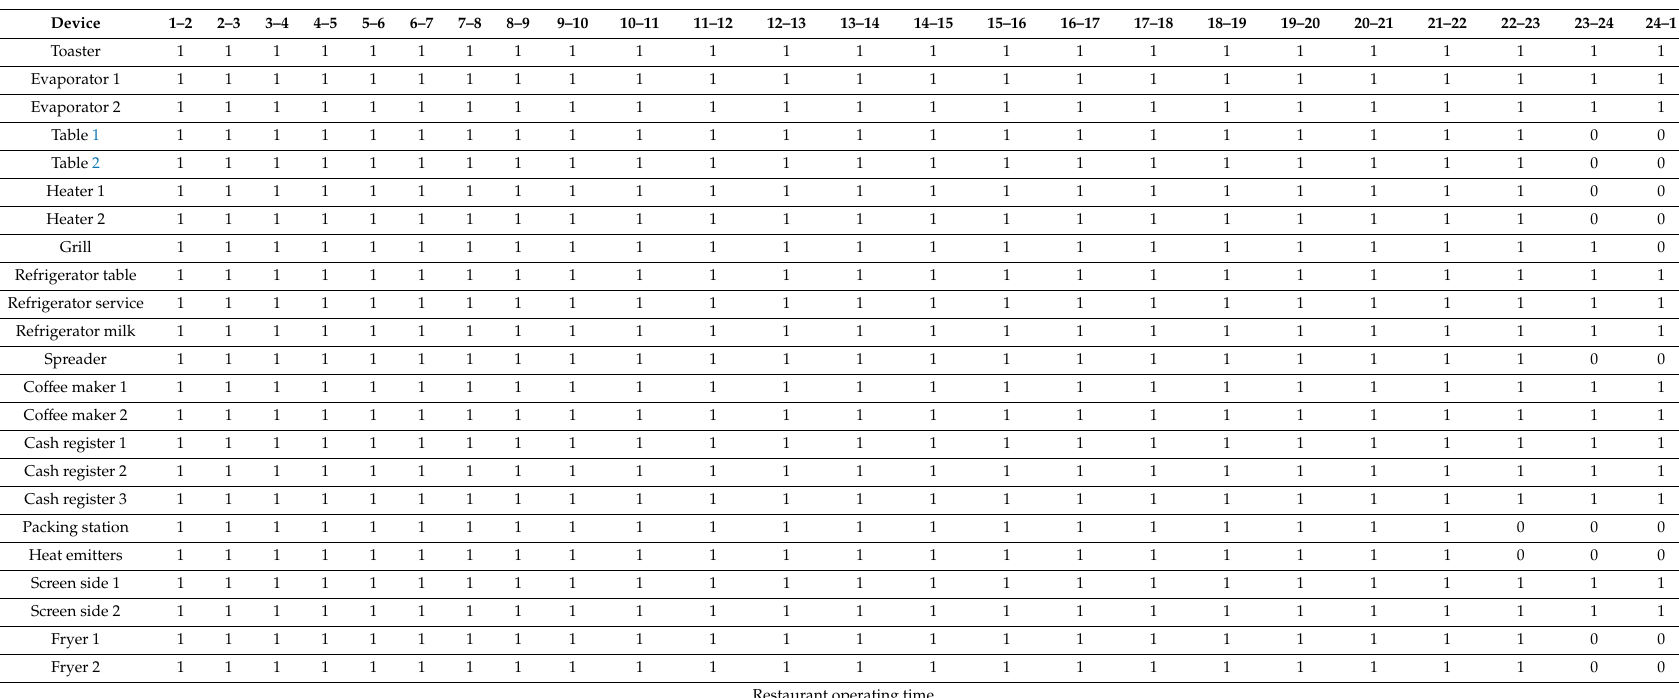
Table 4. Device operation schedule in the